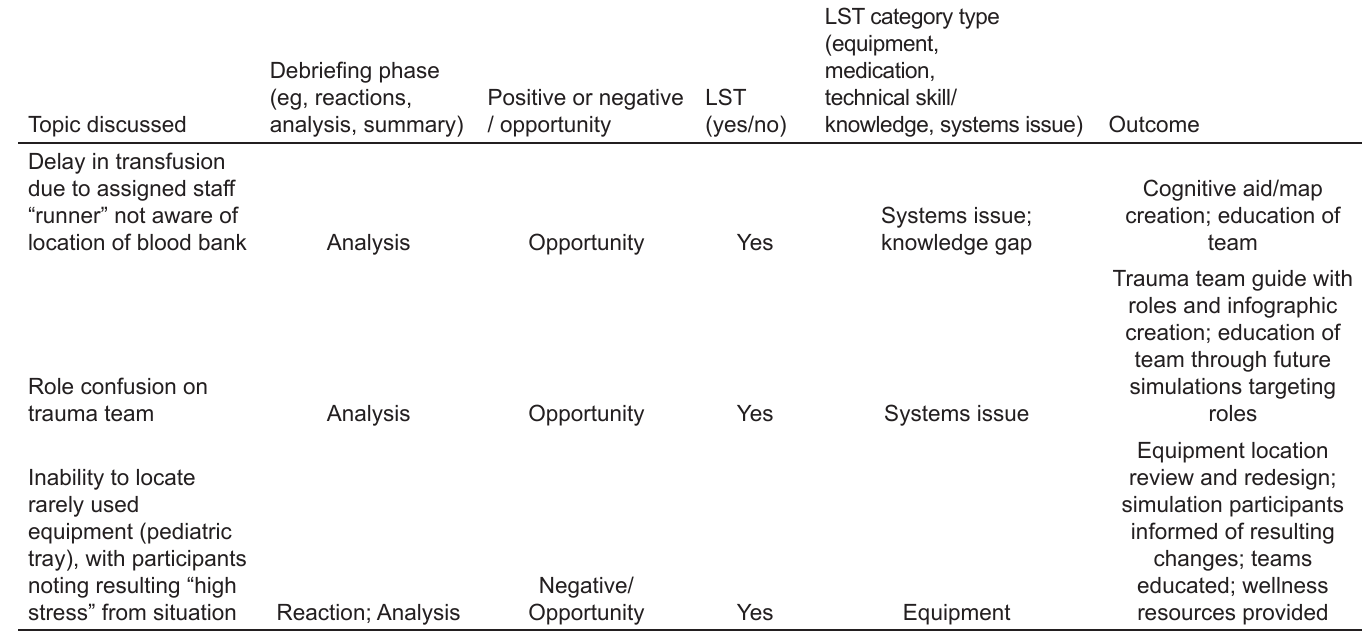
Table 1. Debriefing data outcomes recorded and examples.